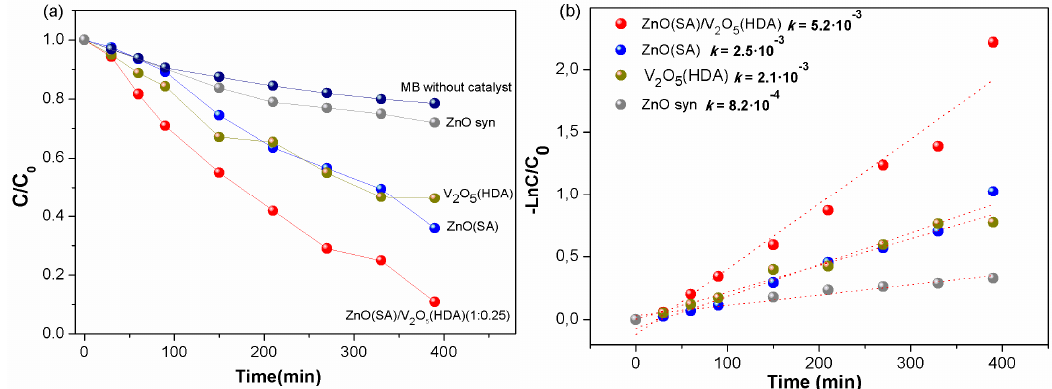
Figure 5. ( a ) Photocatalytic performance of the samples ZnO(SA)/V 2 O 5 (HDA) for the degradation of MB solution and the degradation of MB without photocatalyst. ( b ) Photodegradation kinetics of the selected samples for the degradation of MB solution.